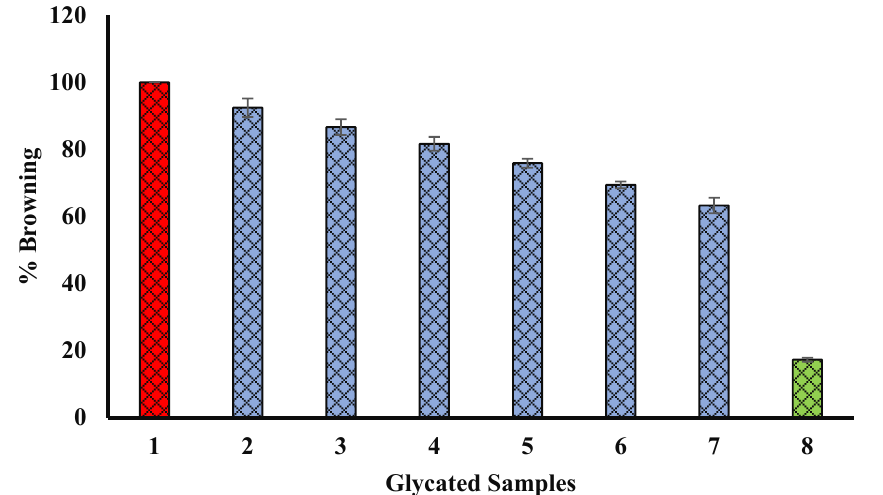
Figure 9. Reduction in % of browning by seed extract. Sample 1 (red column) belongs to BSA kept with glucose for 15 days (100% glycation or browning). Bars 2, 3, 4, 5, 6, and 7 show % of browning of glycated samples with 100, 200, 300, 400, 500, and 600 µg/mL of Ajwa seed extract (blue columns) and % of browning (the degree of glycation) was found to be decreased with an increase in the concentration of seed extract. Bar 8 (green column) shows the % of browning of BSA incubated in the absence of any extract or glucose, and exhibited the least browning (glycation). The results are presented as means ± SEM ( n = 3, p < 0.05).